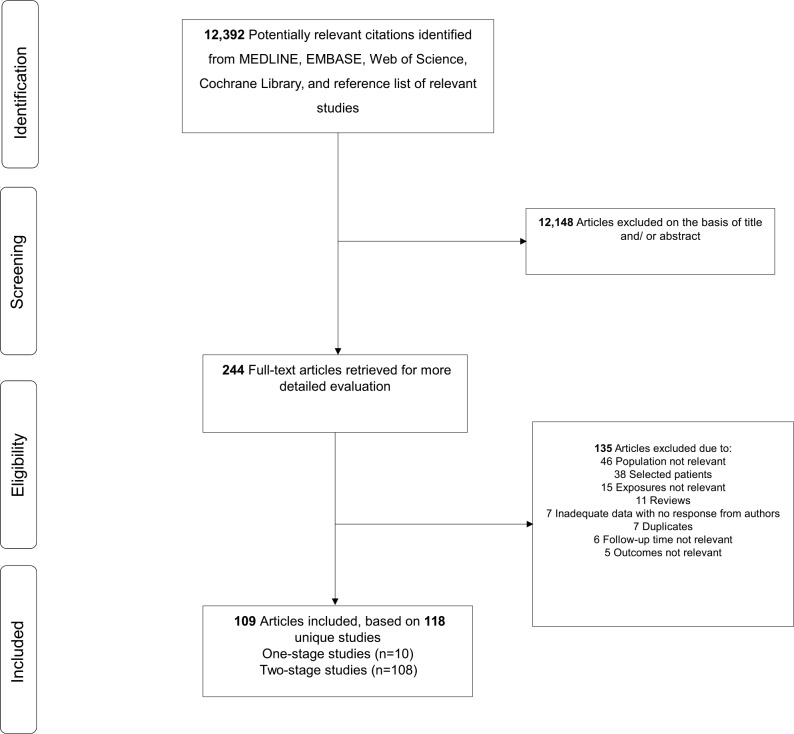
PRISMA Flow Diagram.